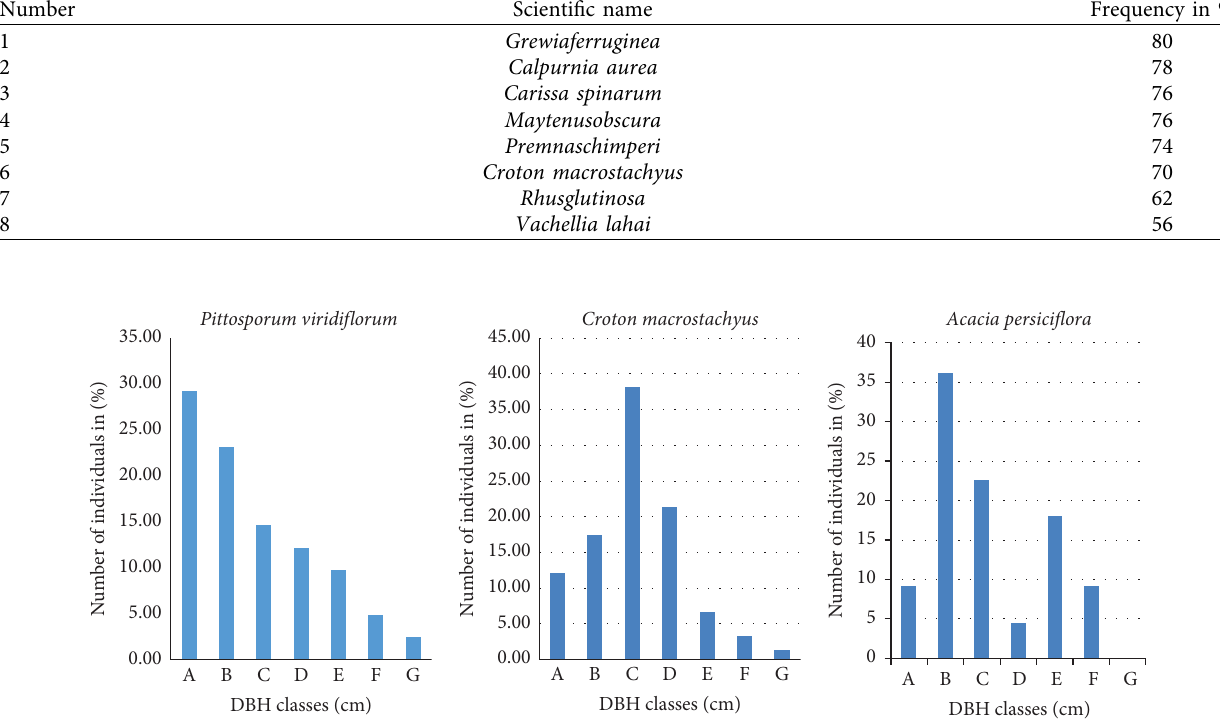
Table 3: Frequency distribution of top 8 woody plant species of St. Michael Church Forest.